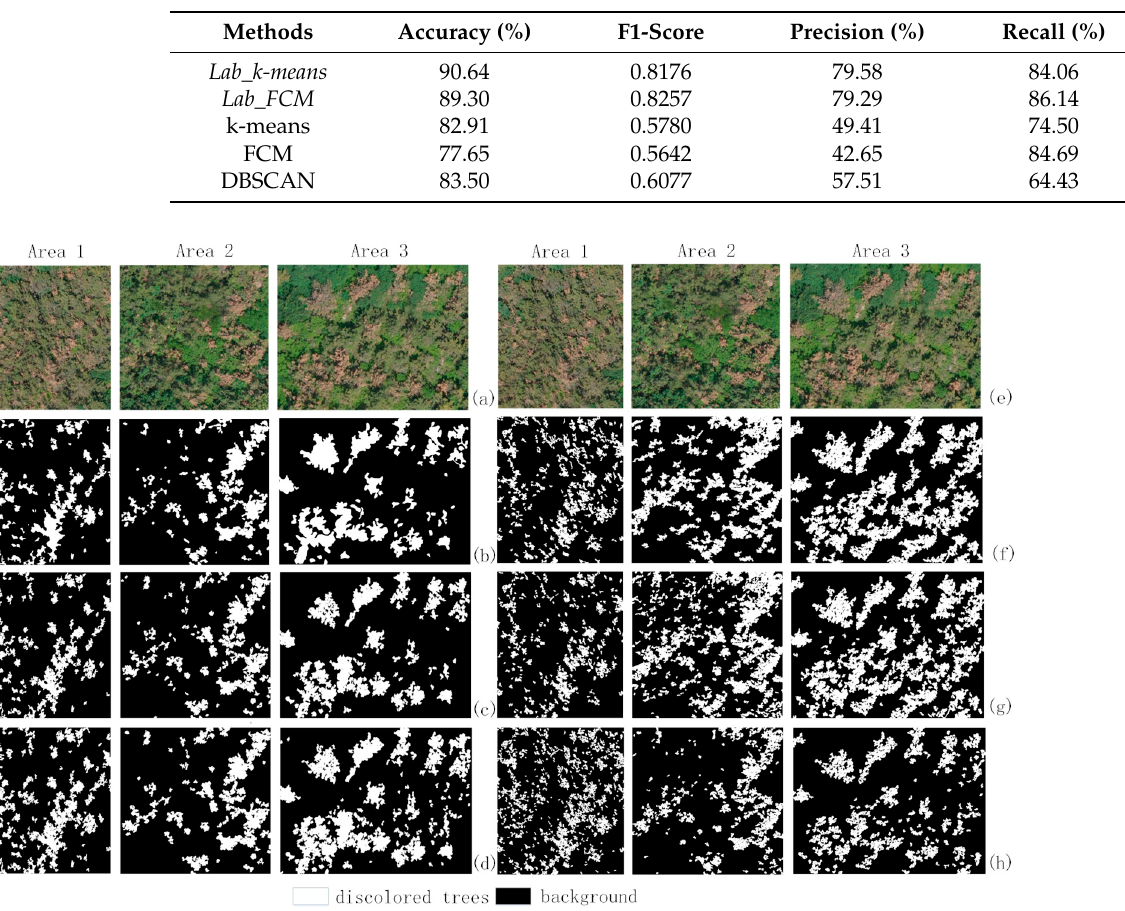
Table 1. The average accuracy of different results extracted by three indices from the three re- gions.